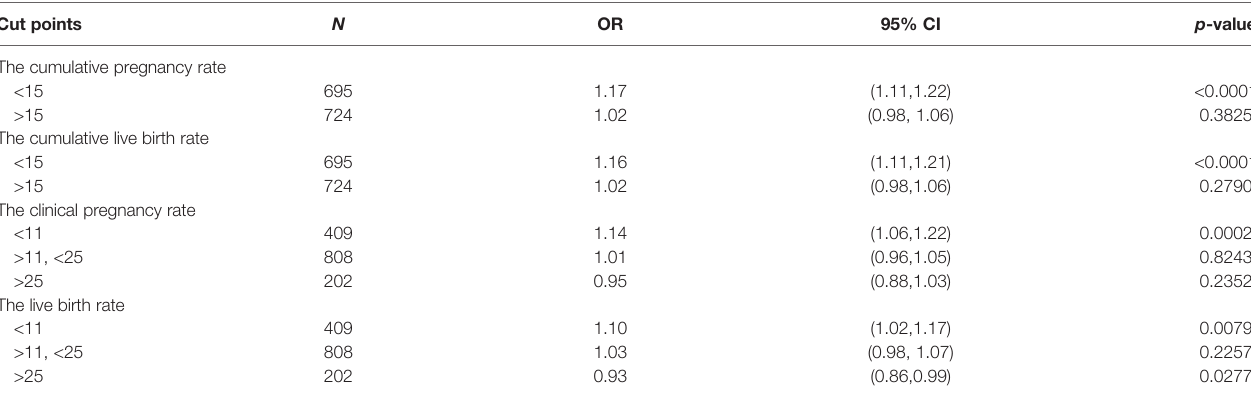
TABLE 4 | The threshold effect analysis of the number of oocytes retrieved and clinical